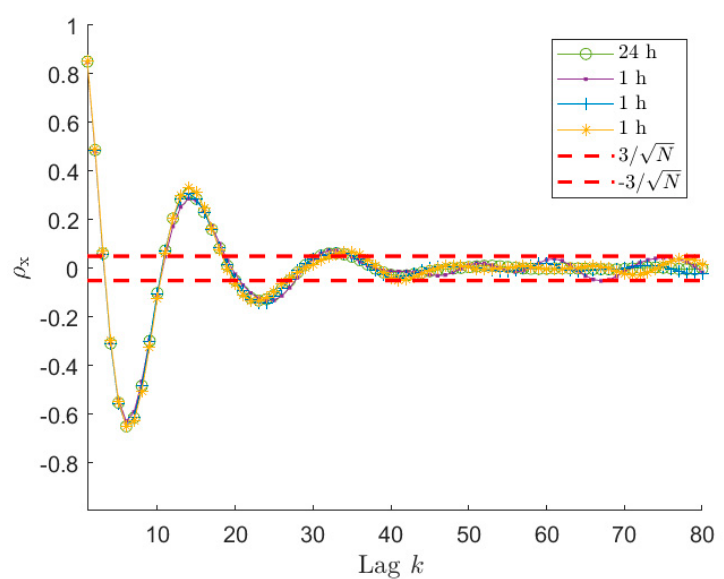
Figure 2. Normalised auto − covariance ρ x curves for a sea state of type 1 in Table 1 for a signal 24 h long and three signals 1 h long, sampled at 1 Hz. The ±3/√𝑁 range is related to the three 1 h long signals. These three signals have ˆ ϕ between 34 and 36, depending on the considered time series.